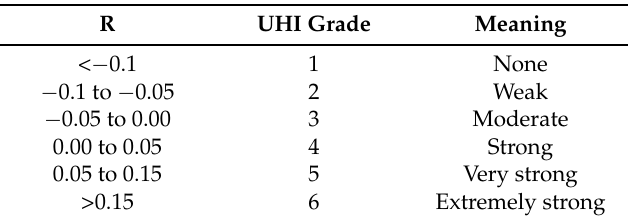
Table 1. Grading standard of